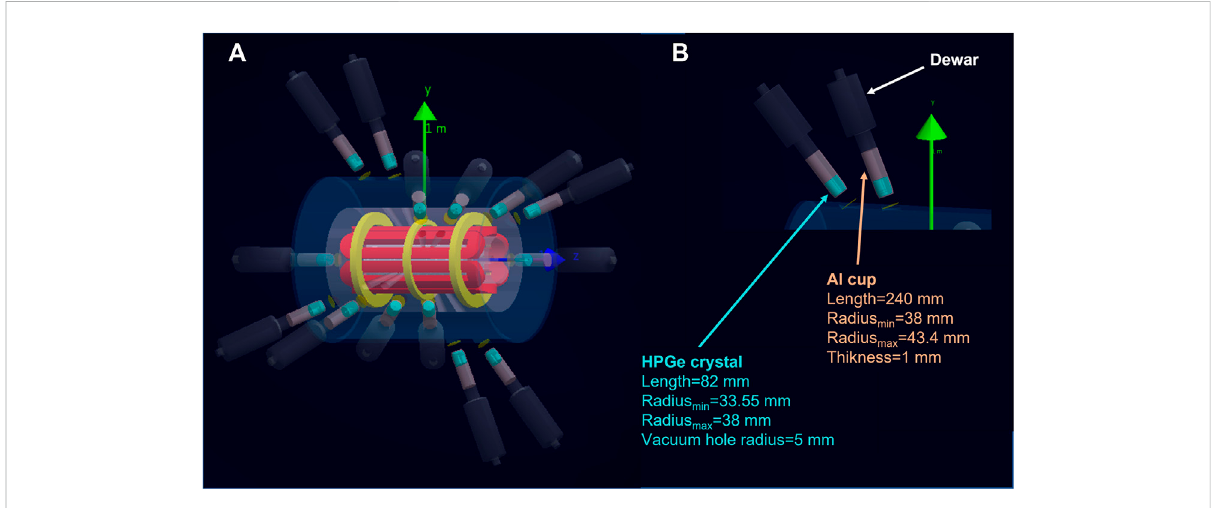
FIGURE 5 (A) Final design of the PANDORA trap with the magnetic system (coils, hexapole, cryostat, and iron yoke) and the array of detectors placed collinearlyateachcollimatorasimplementedinGeant4. (B) DetailsoftheHPGearrayshowthedimensionsofthedetectors(crystal+Alcup)usedin the simulations.